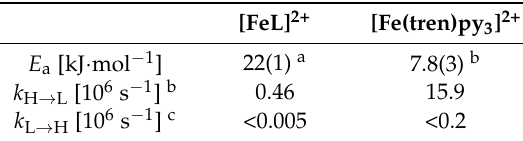
Table 5. Pertinent results from LFP of the iron(II) complexes in MeCN.